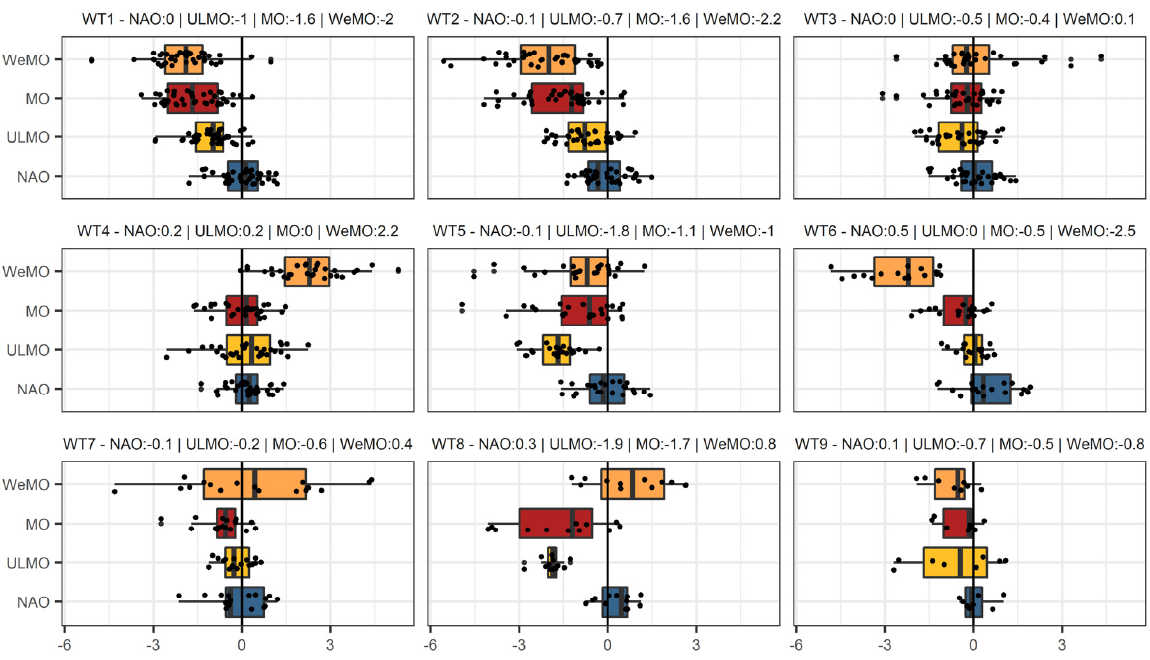
Figure 6. Distribution of daily values of the teleconnection indices for each weather type (WT). The mean value of each teleconnection index for each WT is shown in the header of each plot.